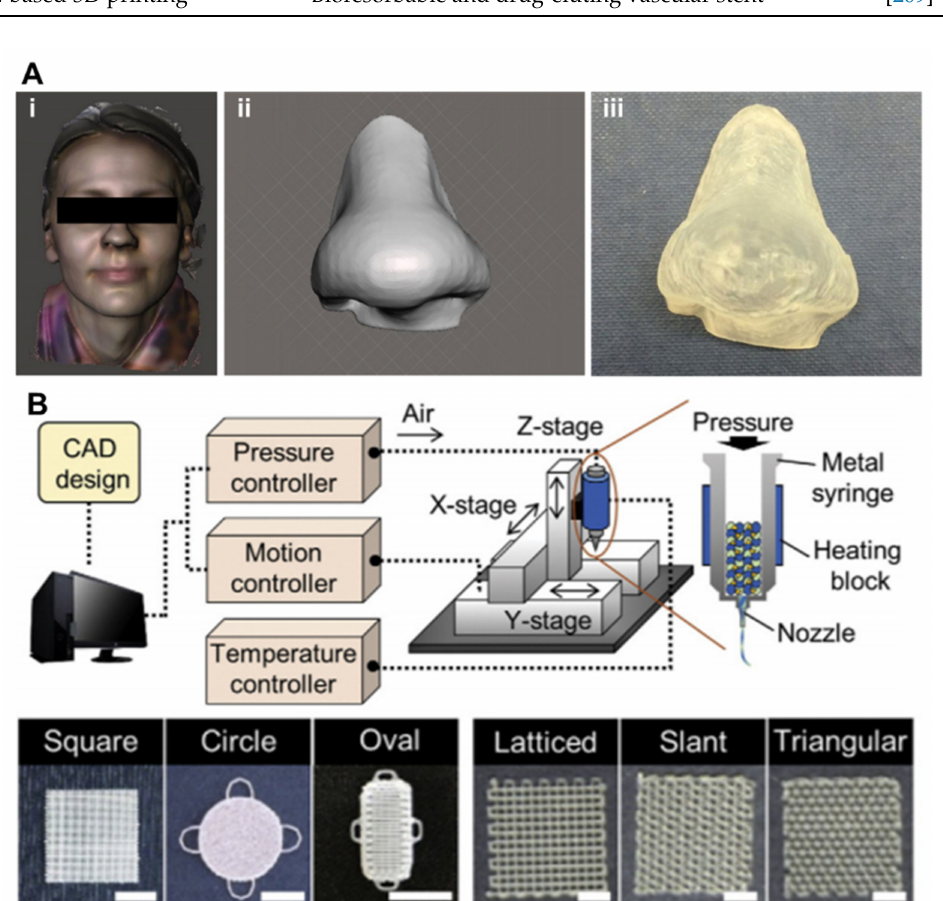
Figure 7. Representative examples of 3D printed transdermal/surgical drug delivery